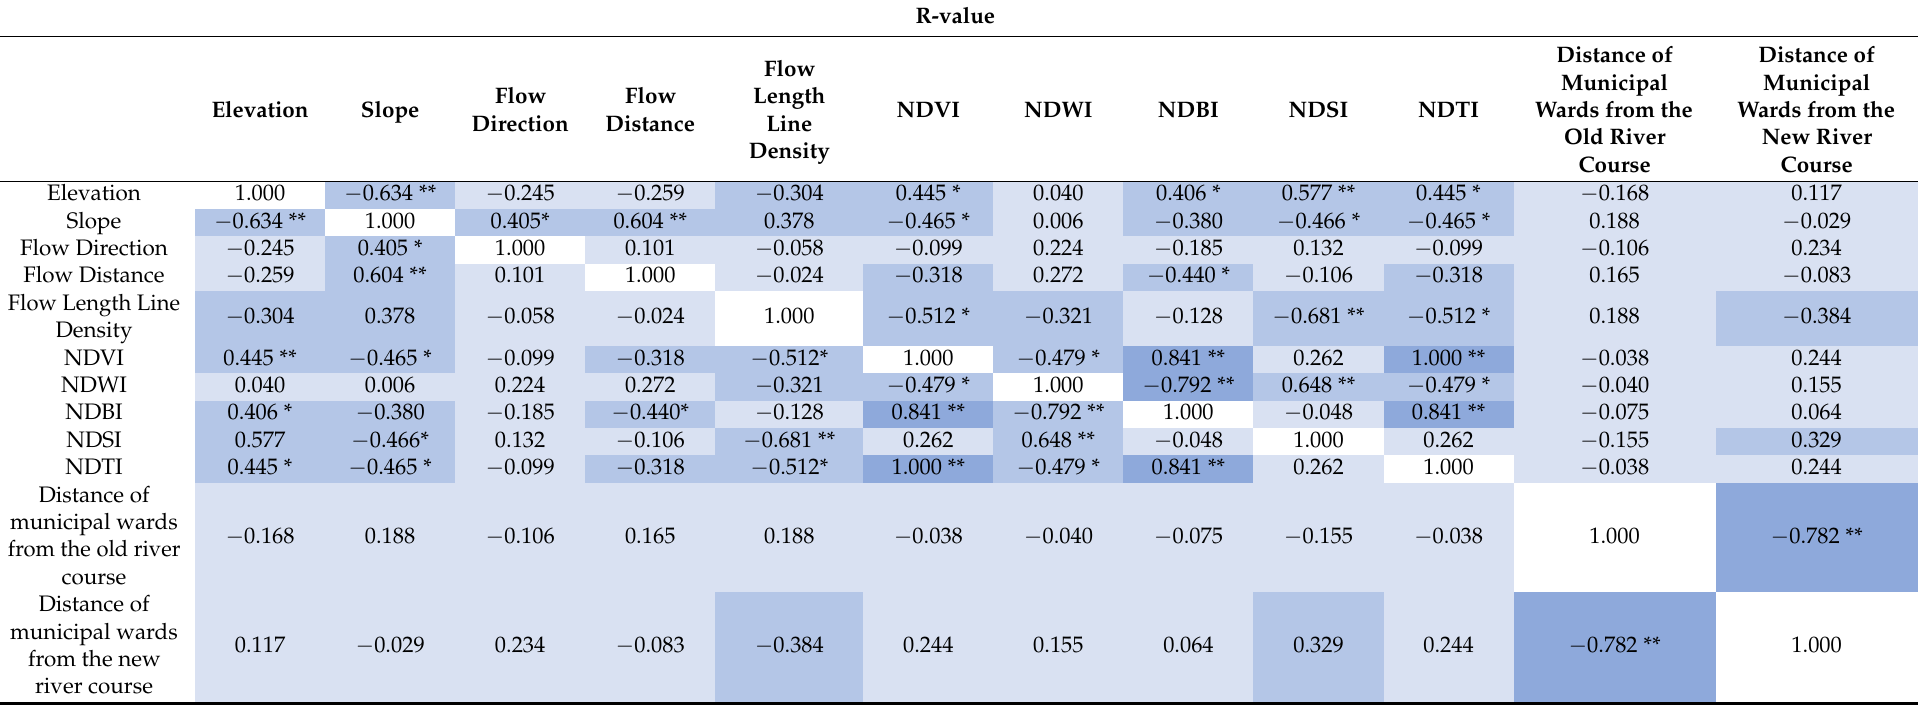
Table 7. Correlation matrix of the selected indicators of flood vulnerability